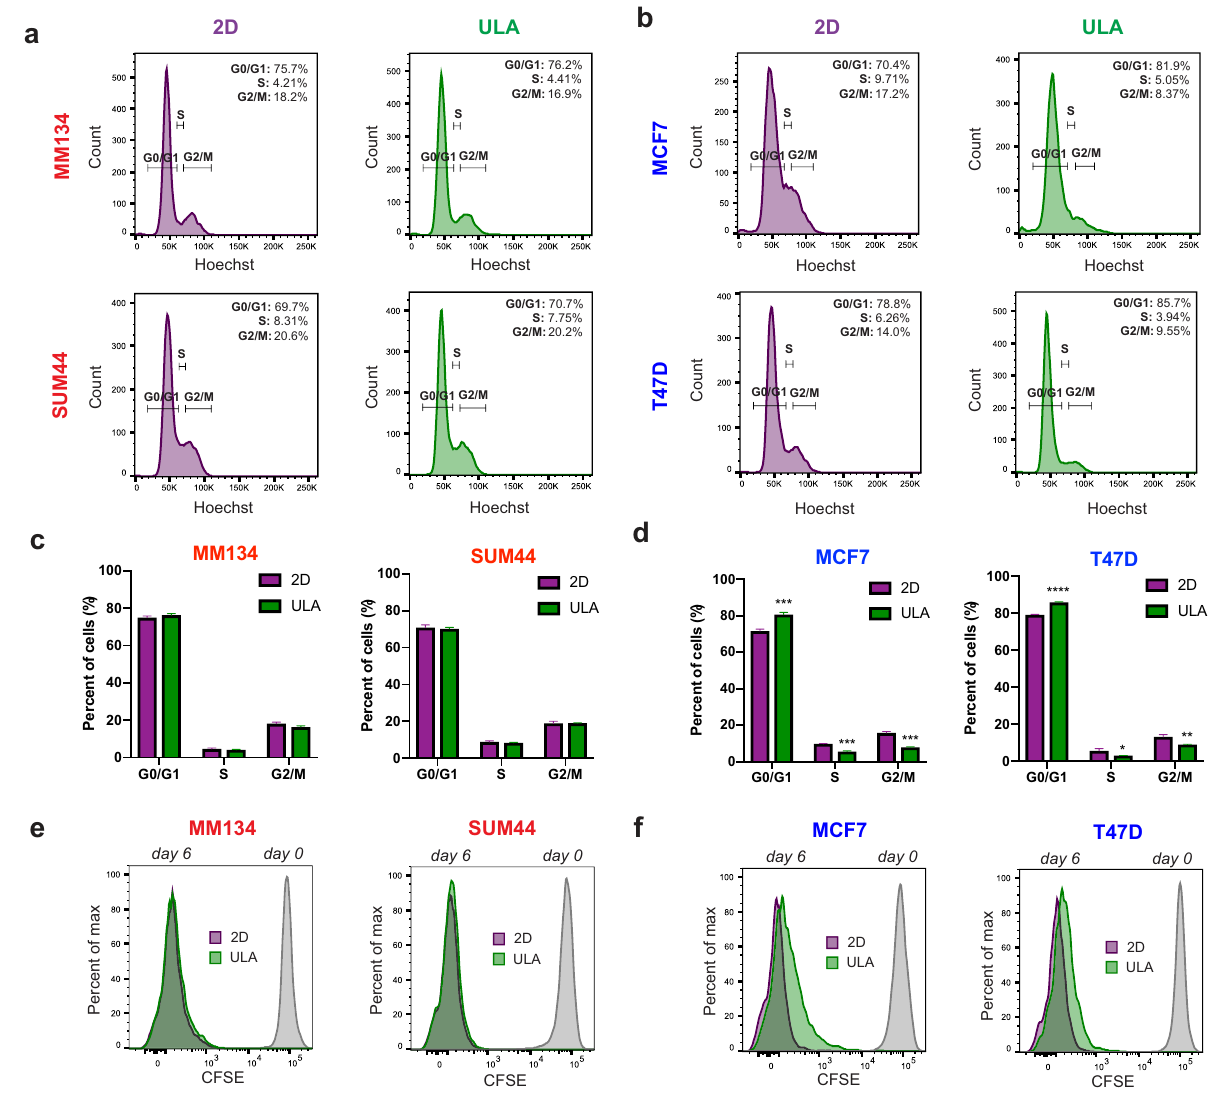
Figure 2. Cell cycle and cell proliferation in ILC and IDC cell lines in 2D and ULA culture. ( a , b ) Representative FACS plots from Hoechst staining of the ( a ) ILC (red) cell lines MM134 (top) and SUM44 (bottom) and ( b ) IDC (blue) cell lines MCF7 (top) and T47D (bottom) after 2 days in 2D (left; purple) or ULA (right; green) culture. ( c , d ) Quantification of the cells in the indicated phases of the cell cycle based on the gating in ( a , b ) in ( c ) ILC and ( d ) IDC cell lines. Data is displayed as mean percentage ± standard deviation (n = 3). p-values are from t tests. *p ≤ 0.05; **p ≤ 0.01; ***p ≤ 0.001; ****p ≤ 0.0001. ( e , f ) CFSE FACS plots of the ( e ) ILC cell lines MM134 (left) and SUM44 (right) and ( f ) IDC cell lines MCF7 (left) and T47D (right) after initial labeling (day 0; grey) and 6 days in 2D (purple) or ULA (green) culture shown as